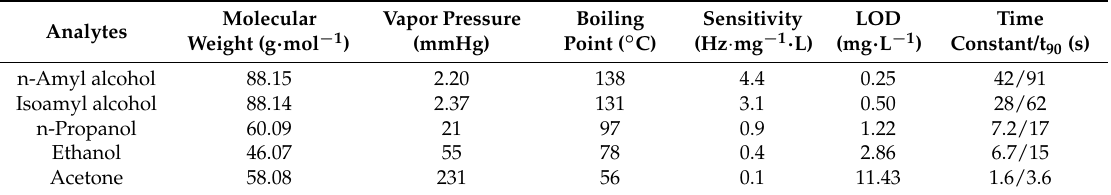
Table 1. Sensitivity and response time of chitosan-based QCM sensor for different types of alcohol.